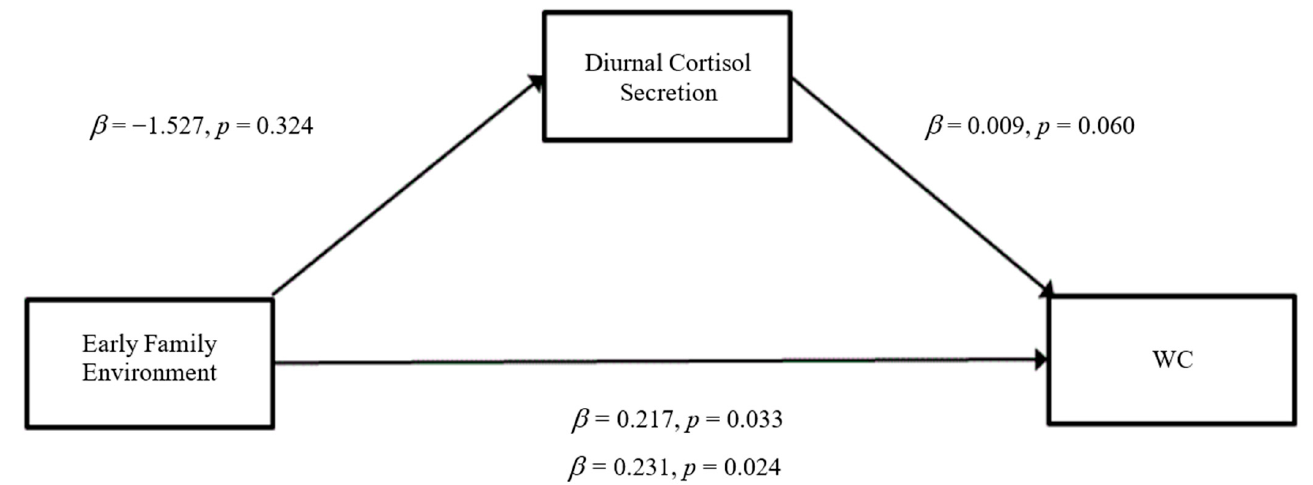
Figure 2. Mediation model for early risky family environment effect on WC through the pathway of diurnal cortisol secretion (Model 4).